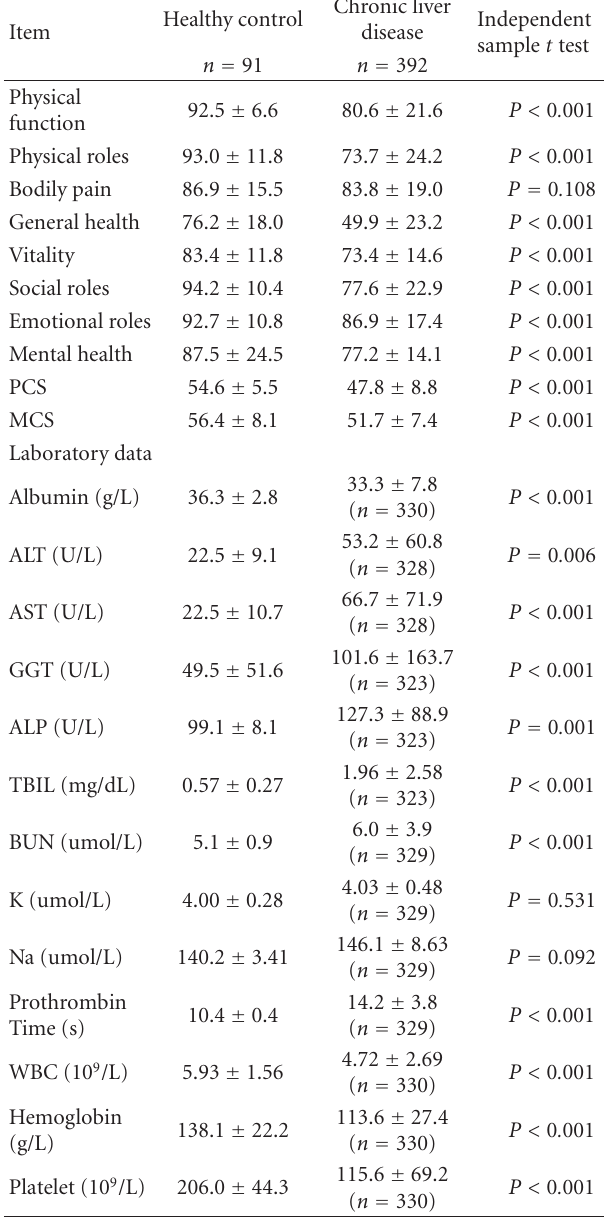
Table 2: HRQOL and clinical data of di ff erent